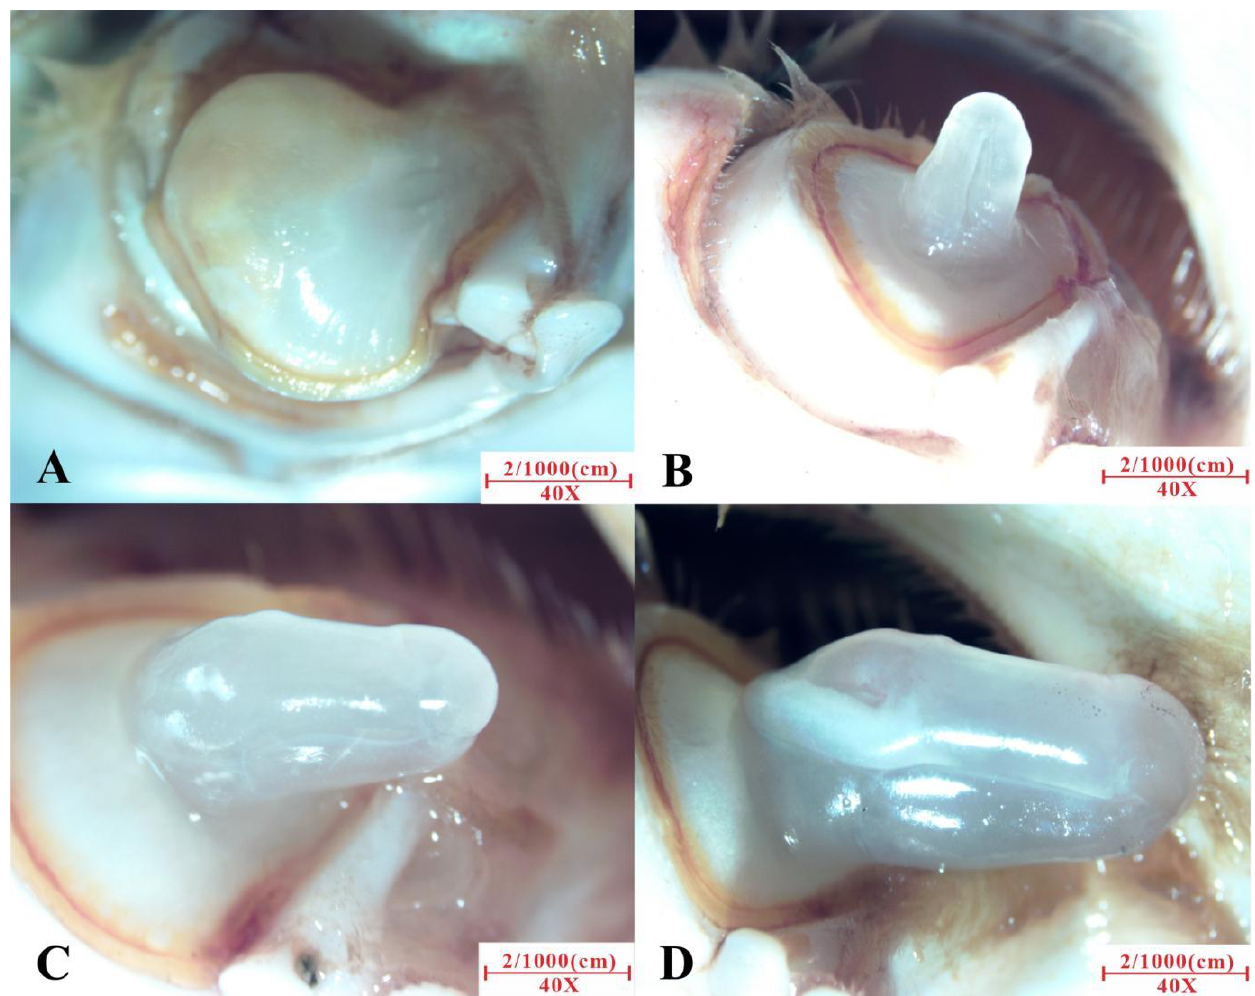
Figure 1. Four landmark developmental stages for the regeneration of the limb in P. trituberculatus . ( A ) Stage I of regenerative limb with wound healing; ( B ) stage II of regenerative limb with regeneration limb bud appear; ( C ) stage III of regenerative limb with segmentation of regeneration limb bud; ( D ) stage IV of regenerative limb with mature regeneration limb bud.